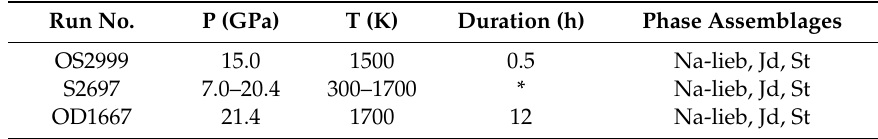
Table 1. Experimental conditions and run products.